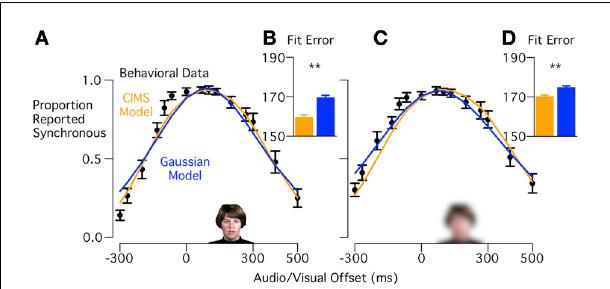
FIGURE 4 | Model fits to behavioral data for Experiment 1 (low visual intelligibility words). (A) Black circles show the behavioral data with visual reliable, low visual intelligibility stimuli, curves show model predictions for CIMS (orange) and Gaussian (blue) models. (B) Fit error showing significantly better fit for the CIMS model ( ∗∗ p < 0 . 001). (C) Mean proportion of synchrony responses and model predictions for visual blurred, low visual intelligibility stimuli. (D) Fit error showing significantly better fit for the CIMS model ( ∗∗ p = 0 . 001).